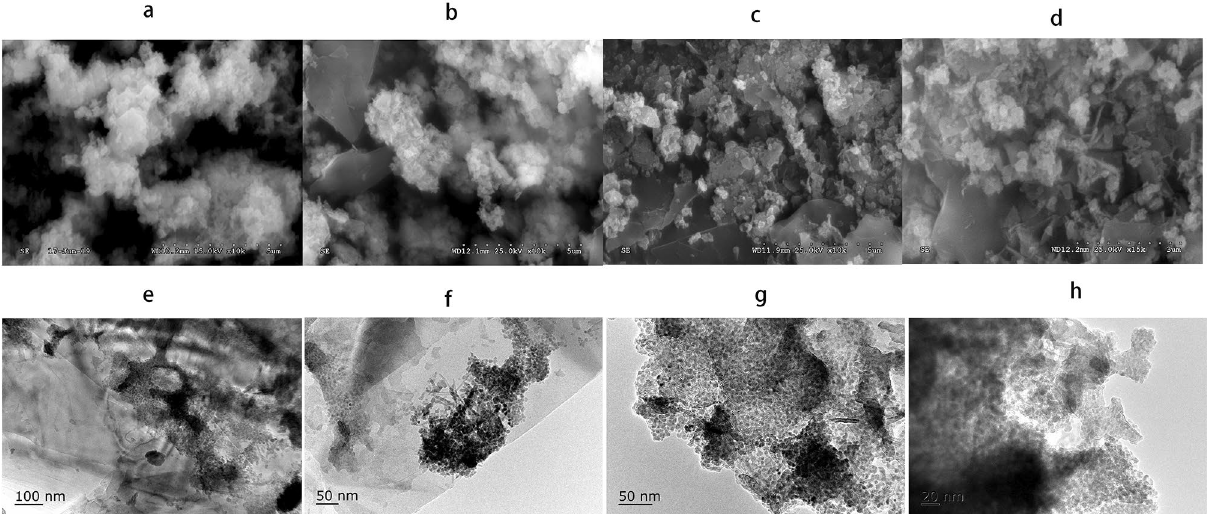
Figure 6. ( a–d ) SEM images of NZV-FeZn, rGO/NZV-FeZn, and rGO/NZV-FeZn(Sb) with micrograph resolution of 5 and 3 μm. ( e–h ) TEM images of rGO/NZV-FeZn with particle sizes of 200, 100, 100, and 50 nm.